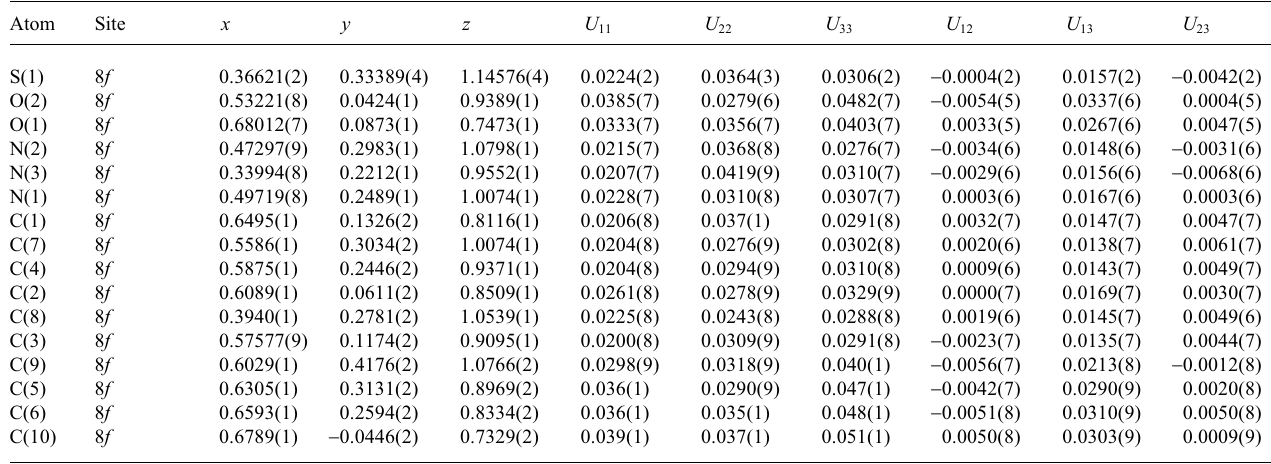
Table 3. Atomic coordinates and displacement parameters (in Å 2 )